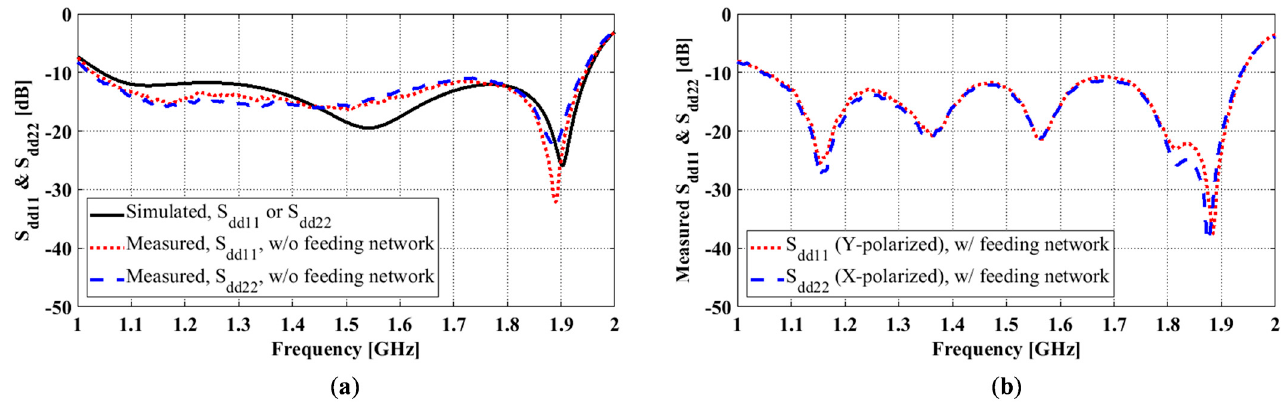
Figure 10. OCROP differential reflection coefficient simulation and measurement: ( a ) Without feeding network; ( b ) With feeding network.